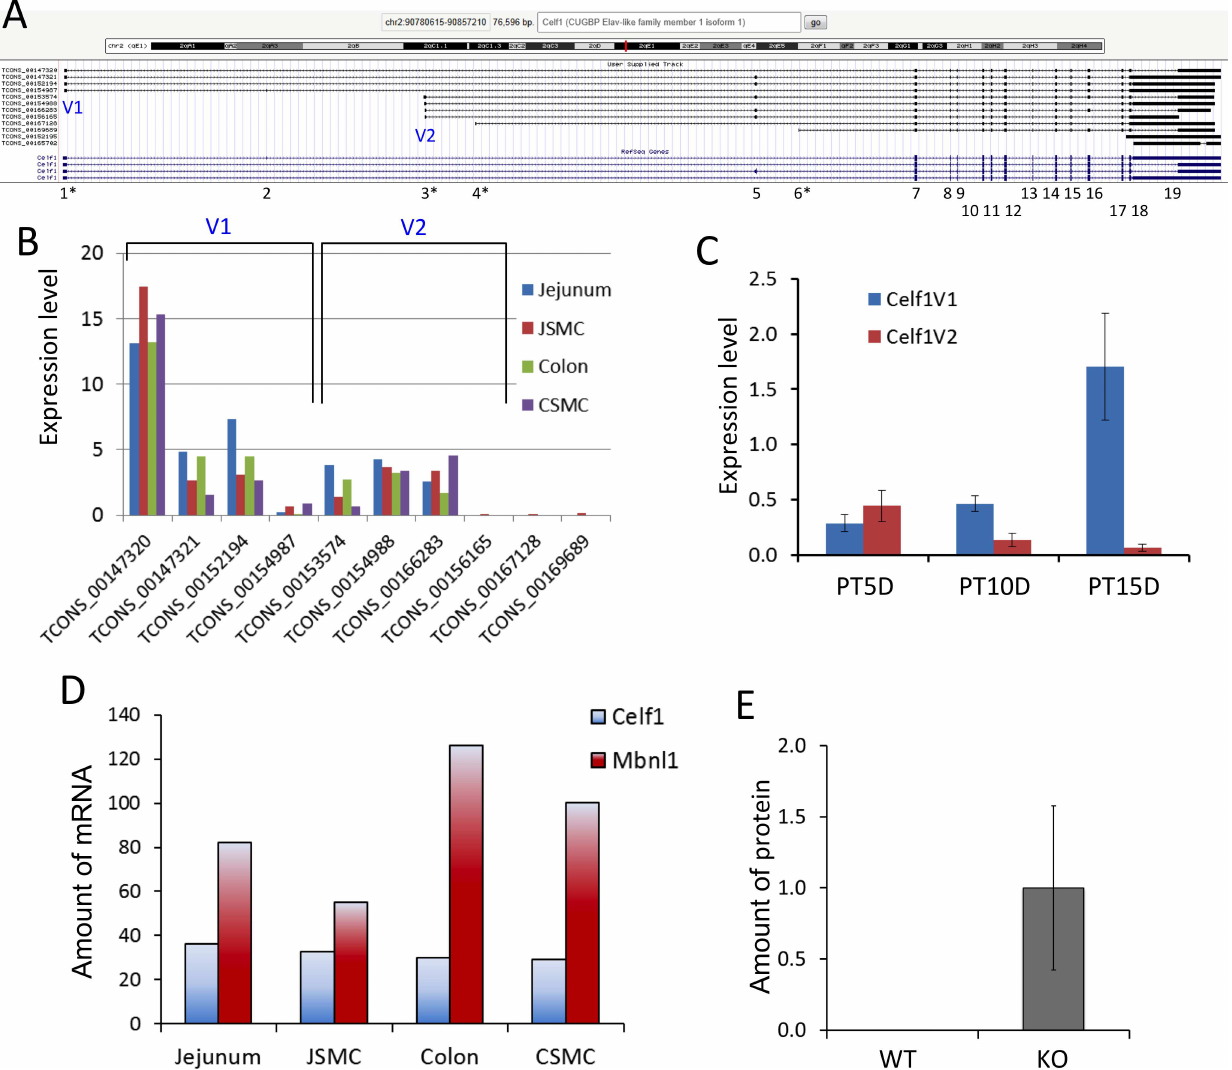
Fig 3. Altered expression of Celf1 transcriptional variants in Srf KO SMC. (A) A genomicmap of Celf1 variants expressedin jejunumSMC. Exons are numbered1–19. Four exons containingalternative transcriptionstart sites are shown by a star ( * ). Two variableregions (V1 and V2) with the predominant transcriptionalstart sites are indicated.(B) Expression levels of Celf1 variants in SMC and jejunaland colonictissue, obtainedfrom RNA-seq data [6]. (C) qPCR data showingexpressionchangesof Celf1 V1 and V2 transcripts at KO days 5, 10, and 15 (n = 3). (D) Comparison of expressionlevels of Celf1 and Mbnl1 in WT jejunum, colon, and their isolated SMC, obtained from RNA-seq data [6]. (E) Inductionof CELF1 protein in KO muscle. Amount of protein expressionwas obtainedfrom LS-MS/MS proteomics